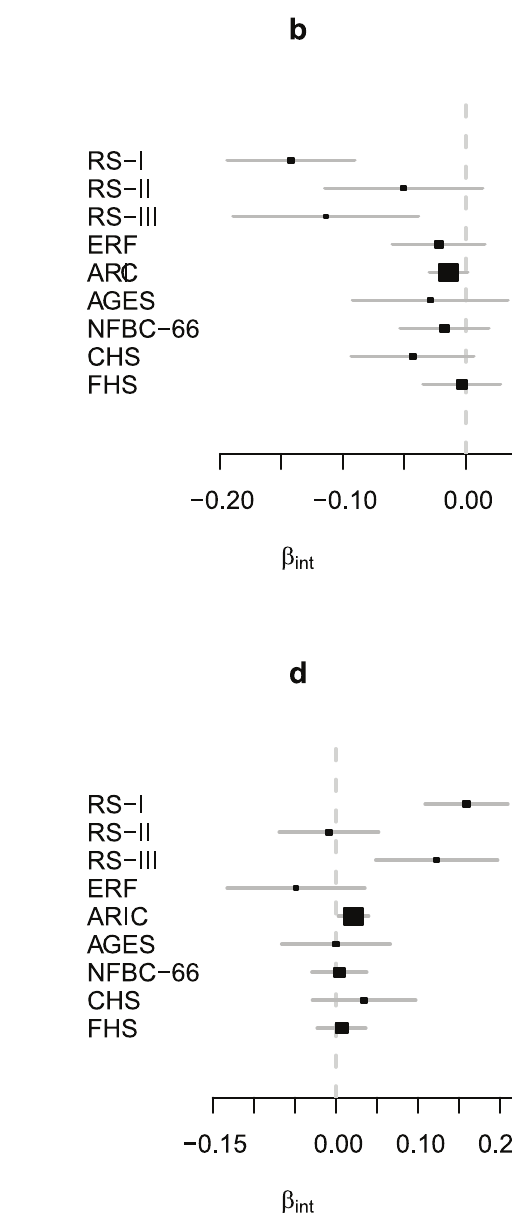
Figure 2. The forest plots for b int of the four most significant interaction terms after meta-analysis of the replication cohorts: rs2315598-rs2853228 (a), rs6848132-rs7863451 (b), rs3756856-rs11758333 (c) and rs4596126-rs11676467 (d). Although the analysis in the discovery and the filtering was done with scaled phenotypes, for these forest plots, the HDL levels are not scaled in the Rotterdam Study cohorts.